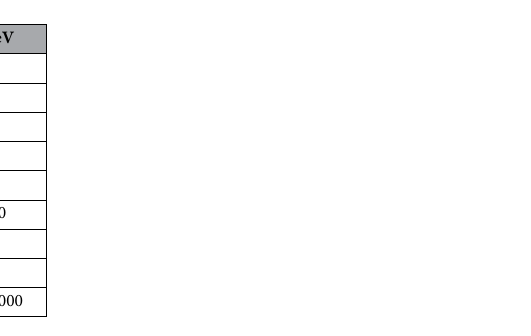
Table 1. Relationships between lightning and X-ray and gamma-ray radiation parameters. r 0 = 0.01 m, f = ω 2 π .